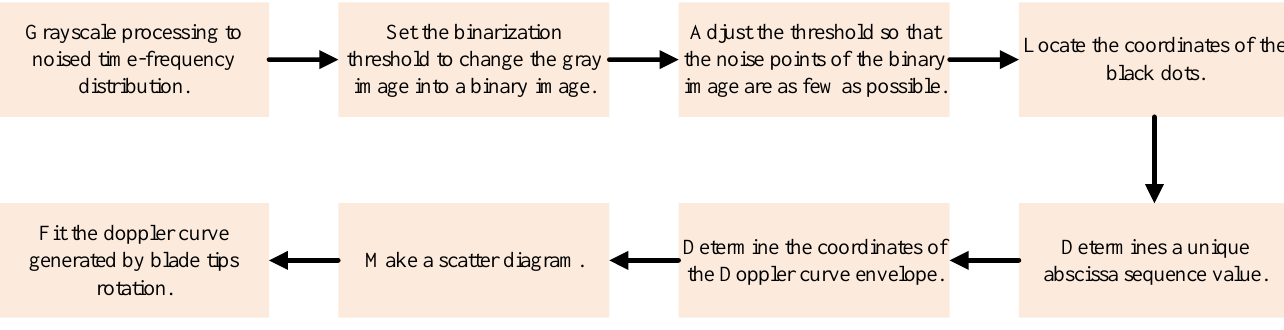
Figure 4. The parameter-extraction flowchart of helicopter rotors based on fitting of time – frequency distribution .